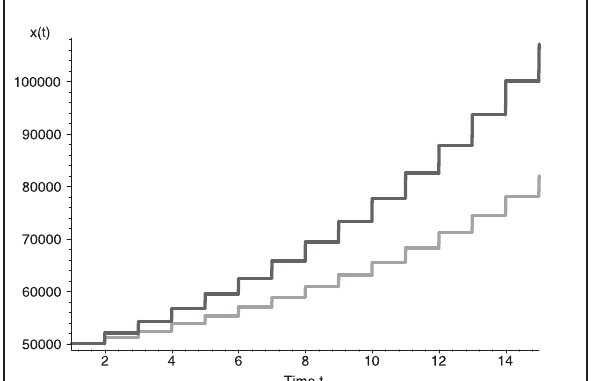
Figure 1. Population size: dark—cooperation, light—Nash